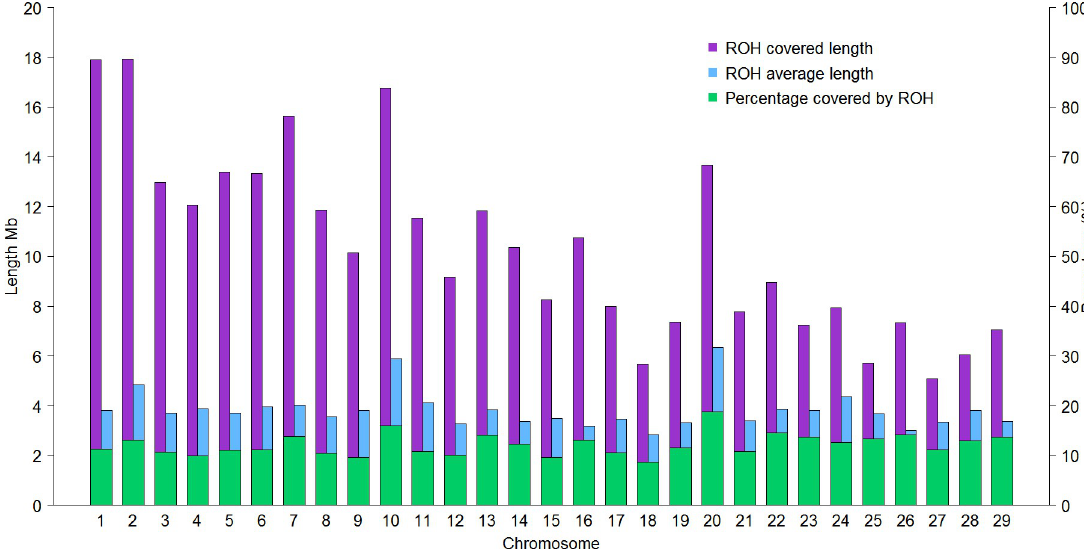
Fig 3. Length, average length and percentage of the genome covered by ROH in each chromosome in the Mexican Holstein population.